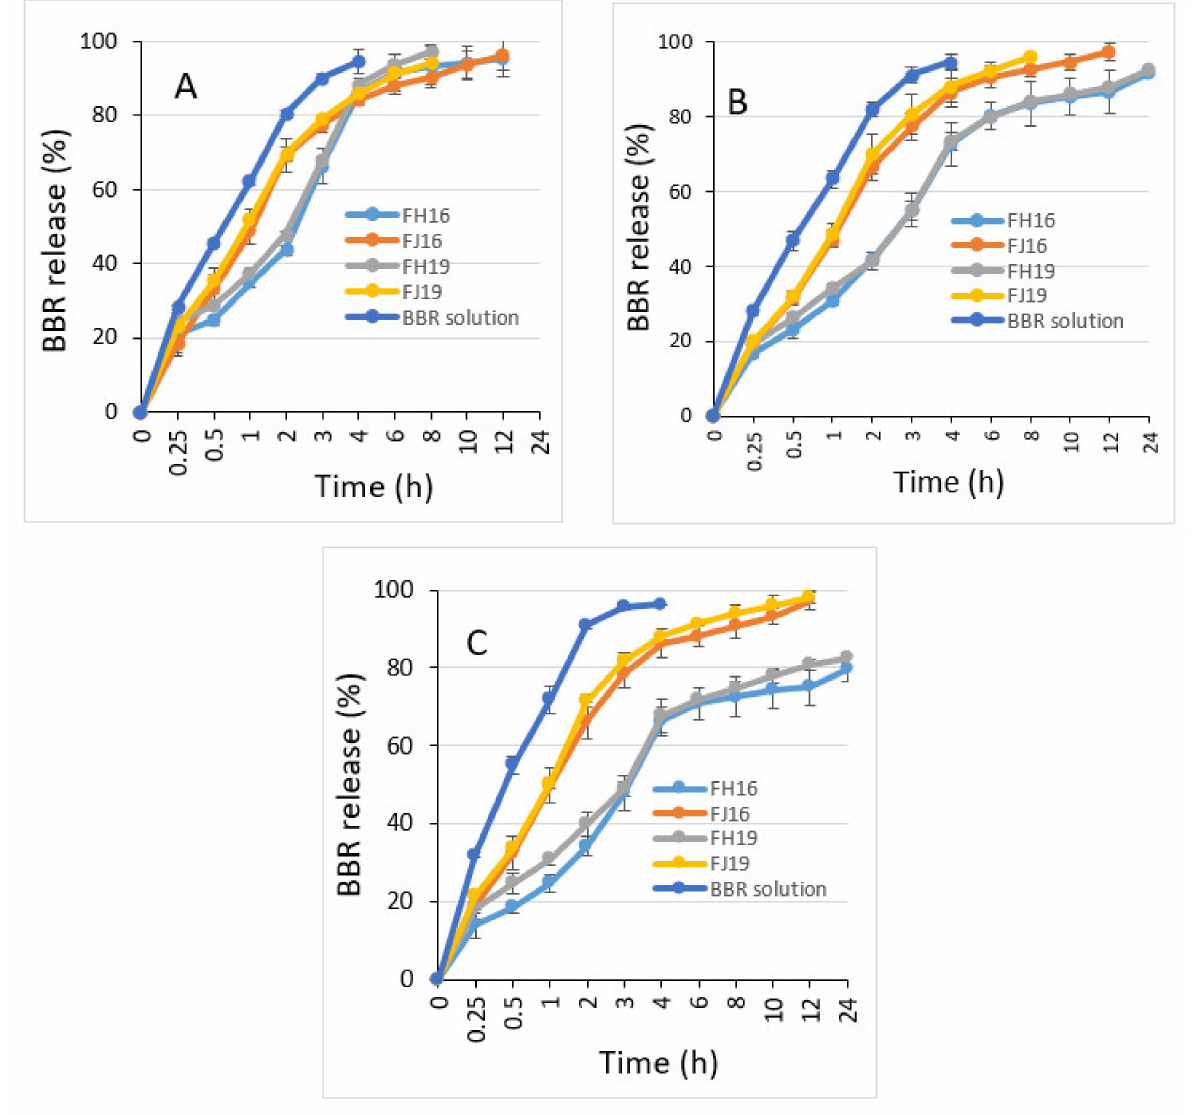
Figure 9. The in vitro berberine (BBR) release of the liposomes prepared by the thin-film hydration (FH16, FH19) and ethanol-injection (FJ16, FJ19) methods. ( A ) The dissolution tests ( n = 3) were carried out in three different dissolution media (at 37 ◦ C). ( B ) Diluted 0.1 N hydrochloric acid (HCl) solution (pH 1.2). ( C ) Phosphate buffer saline (pH 4.5). Phosphate buffer saline (pH